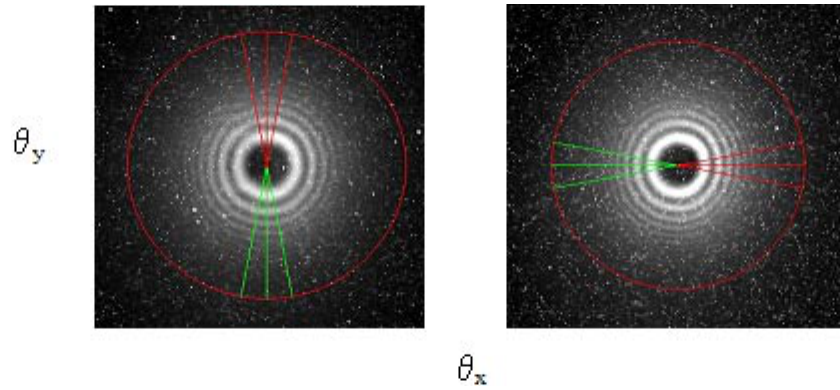
FIG. 6. (Color) OTRI patterns taken with a 650 nm (cid:13) 10 nm bandpass filter at a vertical waist (left) and a horizontal waist (right) with overlays of sectors used to produce averaged vertical and horizontal line